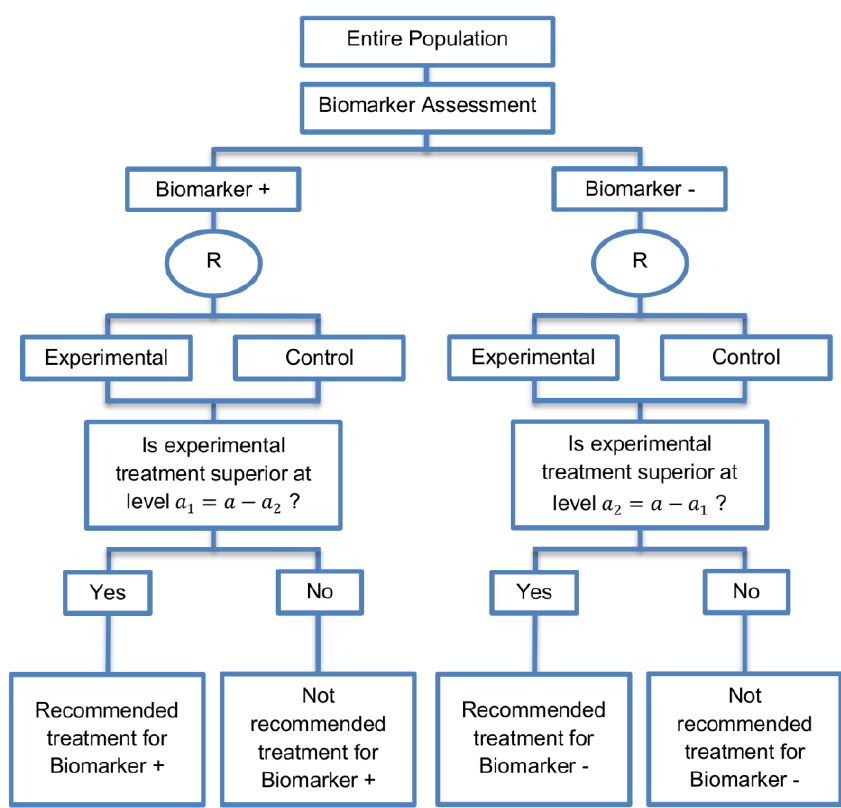
Figure 6. Parallel Subgroup- Specific design. “R” refers to randomization of patients.